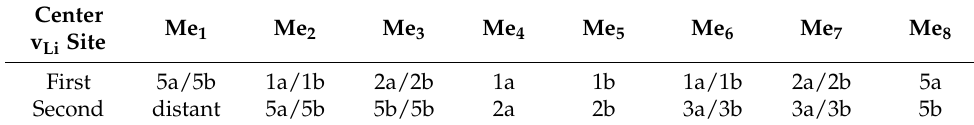
Figure 7. A projection of lithium niobate crystal lattice on xy plane ( a ) and 3D model ( b ) with shell numbers for an im- purity substituted for Li + ion (sizes of all ions were artificially changed in order to make clear positions of cation ions). Hatched circles represent two vacancies of Li + ions for Nd 4 center.